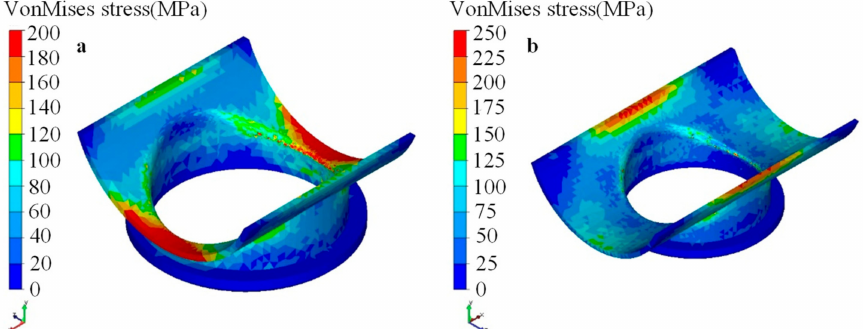
Figure 15. Distribution of stress for lower die with di ff erent length (stroke was 430 mm): ( a ) short x length; ( b ) long x length.